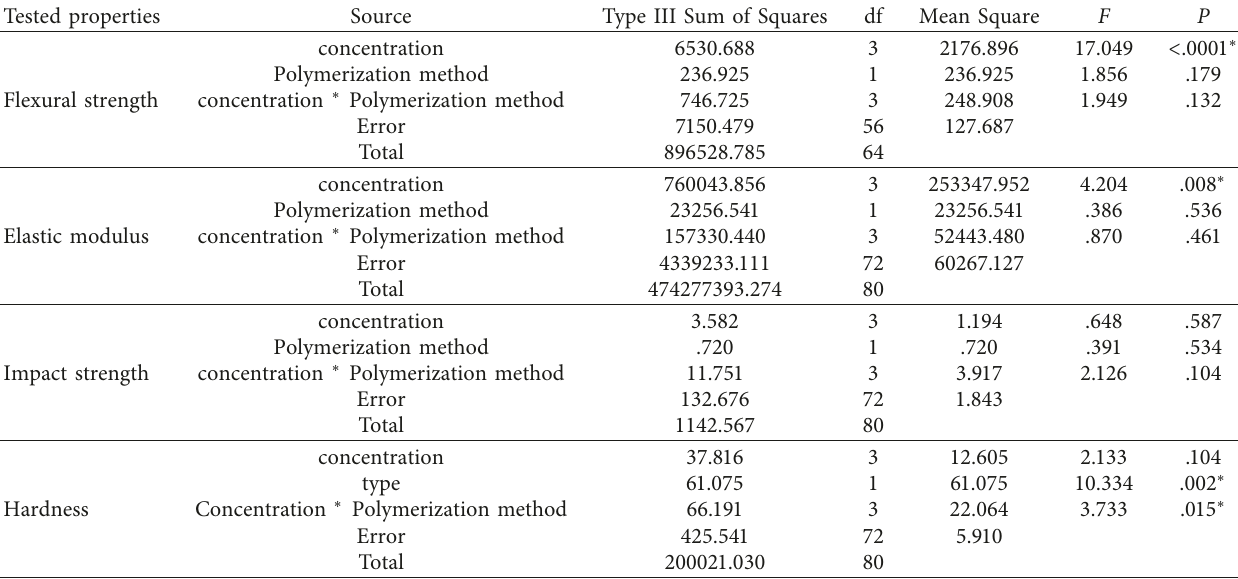
Table 3: Combined effect of concentration and polymerization method on tested properties by using Two-way ANOVA. Tested properties